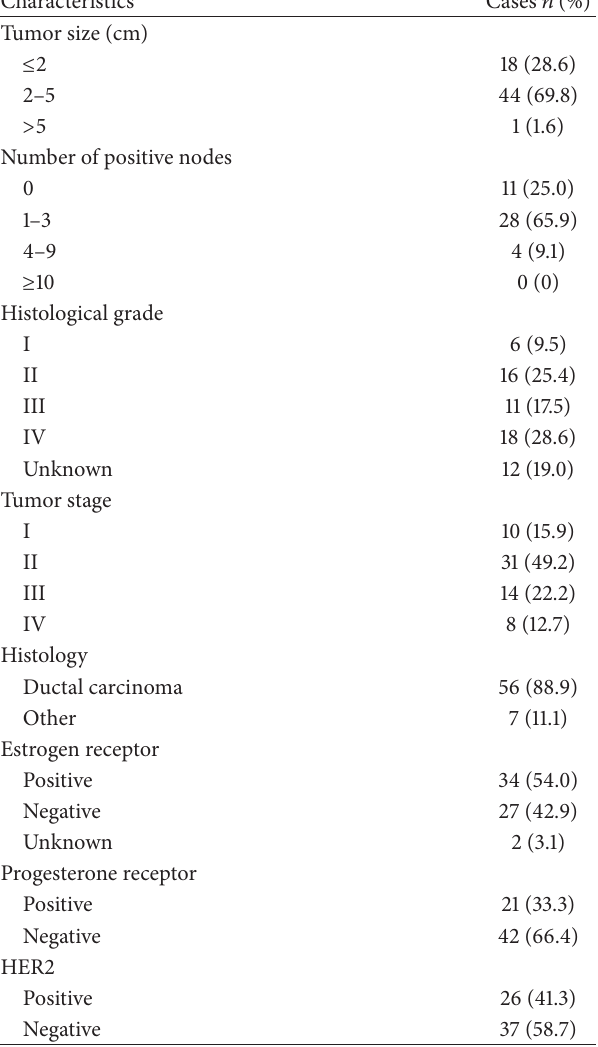
Table 1: Clinical and pathological characteristics of breast carci- noma